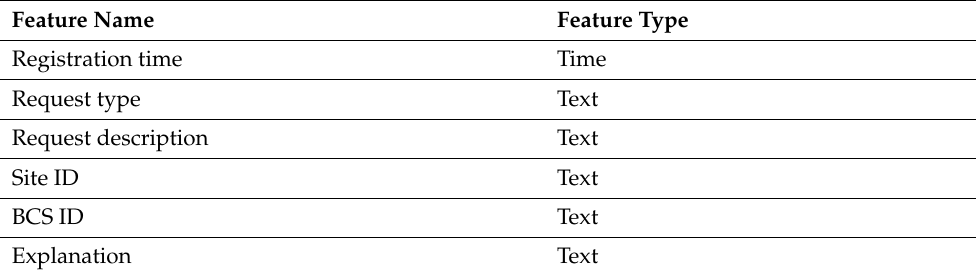
Table 8. The data characteristics of subscribers’